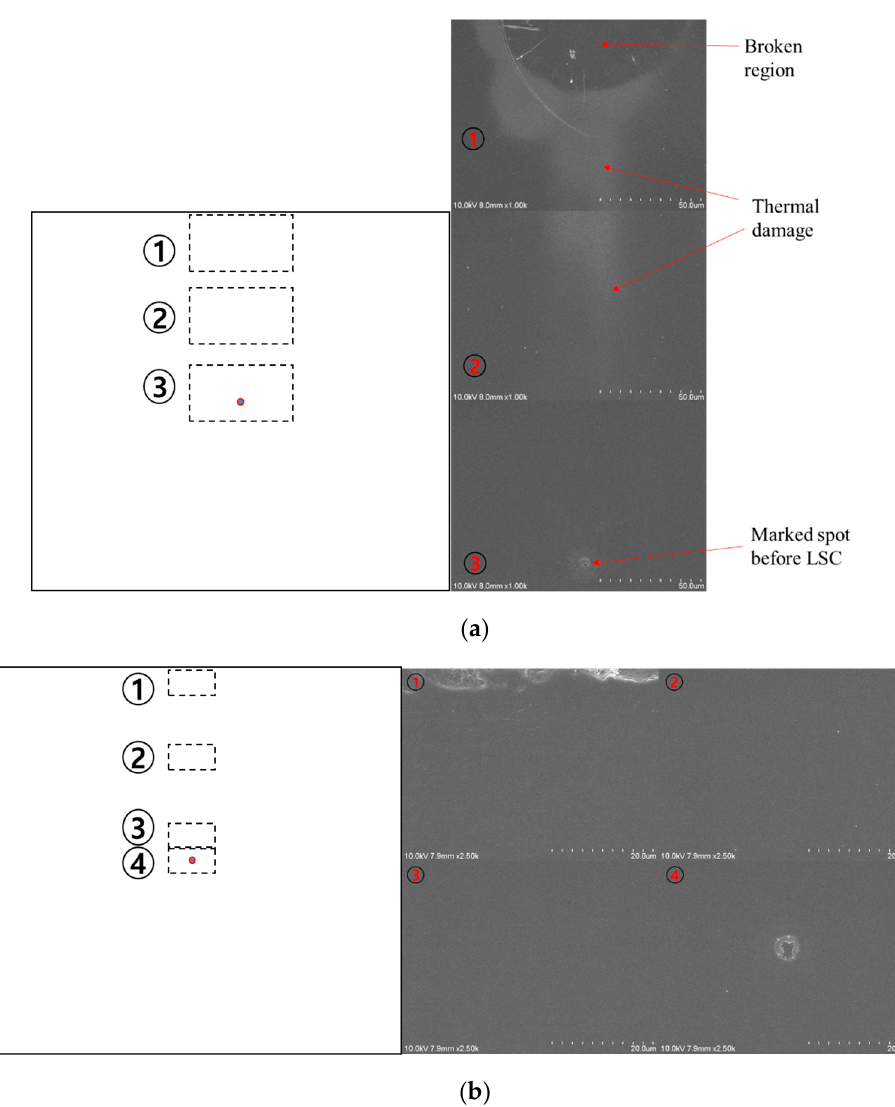
Figure 11. Damage to the glass substrate according to gap distance observed by SEM: ( a ) the gap distance = 10 µ m; ( b ) the gap distance = 20 µ m.